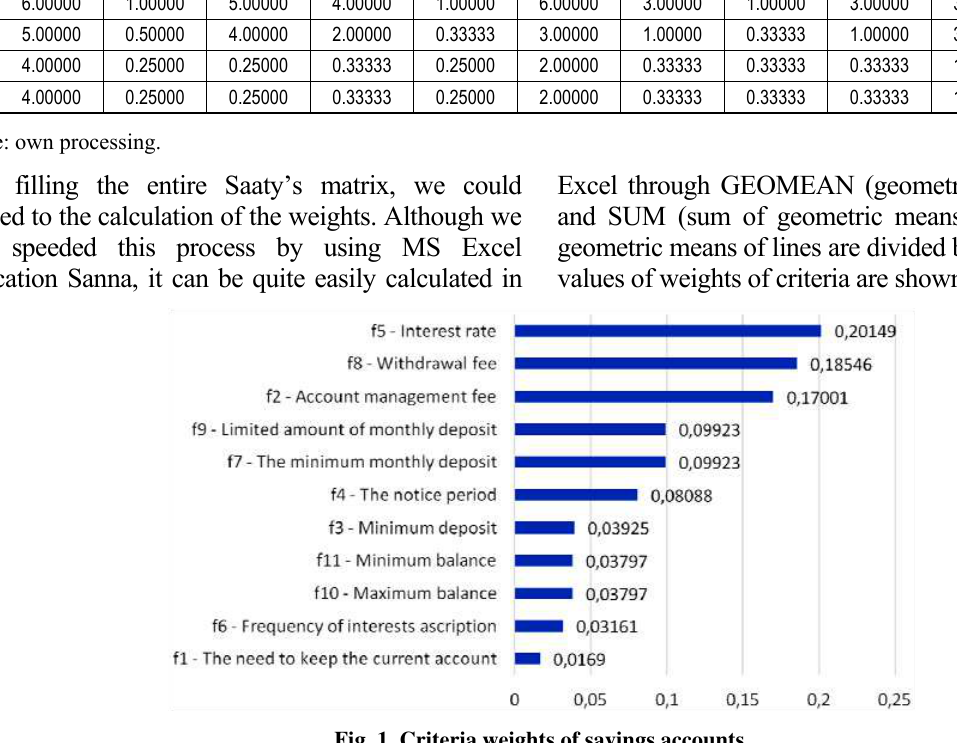
Fig. 1. Criteria weights of savings